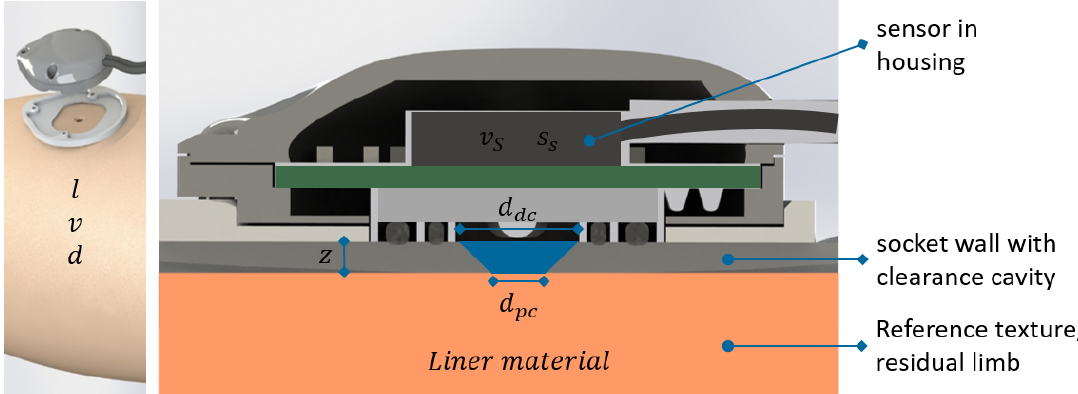
Figure 3. Illustration of factors and their influencing domain: the measuring task defines the factors distance l , velocity v and direction d ( left ). Calibration velocity v s and sensor sensitivity s s can be adjusted in the sensor settings. The thickness of the socket wall leads to the measuring distance z , the clearance cavity is defined by the proximal and distal diameter d pc respectively d dc . Different liner materials serve as reference